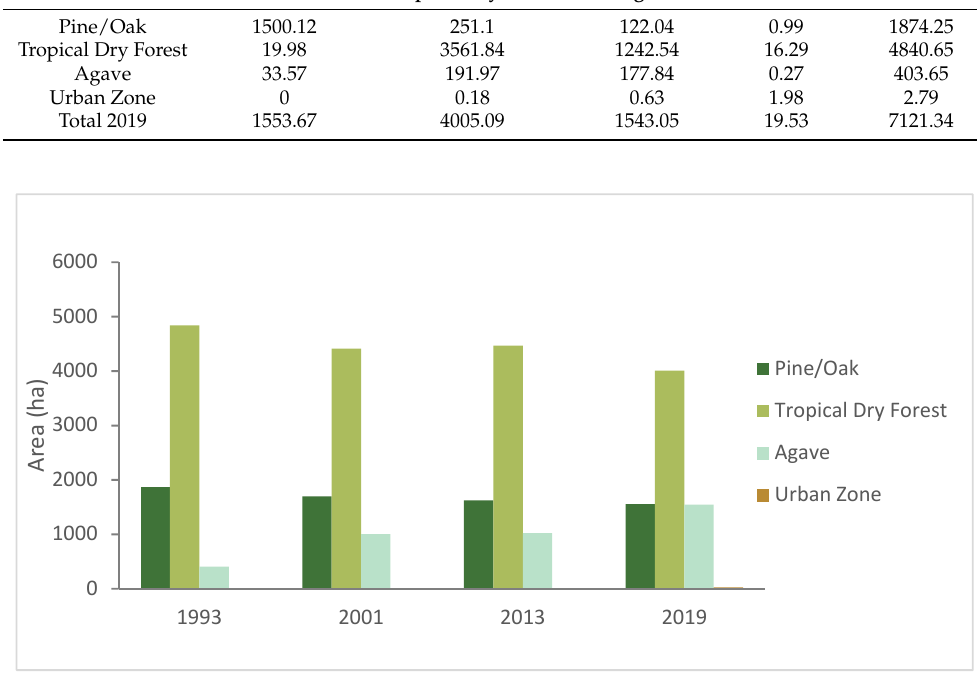
Figure 4. Graph showing the LULC area for each category during the study period. Table 5. Table showing the percentages of LULC for each year of study.